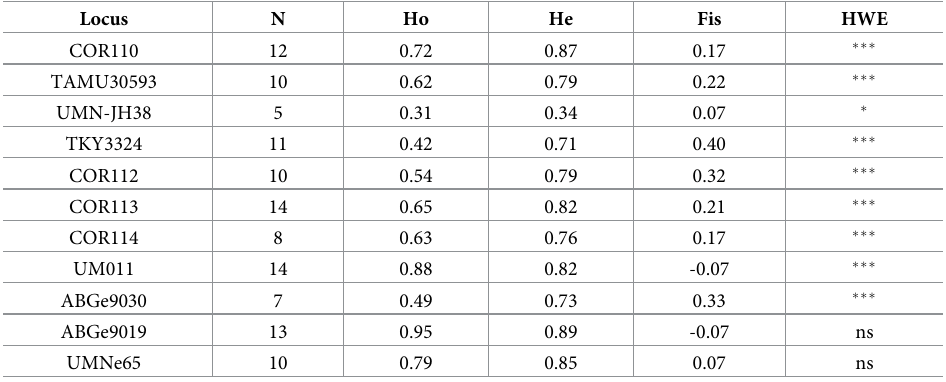
N, number of identified alleles; Ho, observed heterozygosity; He, expected heterozygosity; Fis, MHC microsatellite locus inbreeding coefficient; HWE, a departure from the Hardy-Weinberg equilibrium ( � p < 0.05; ��� p < 0.0001; ns, not